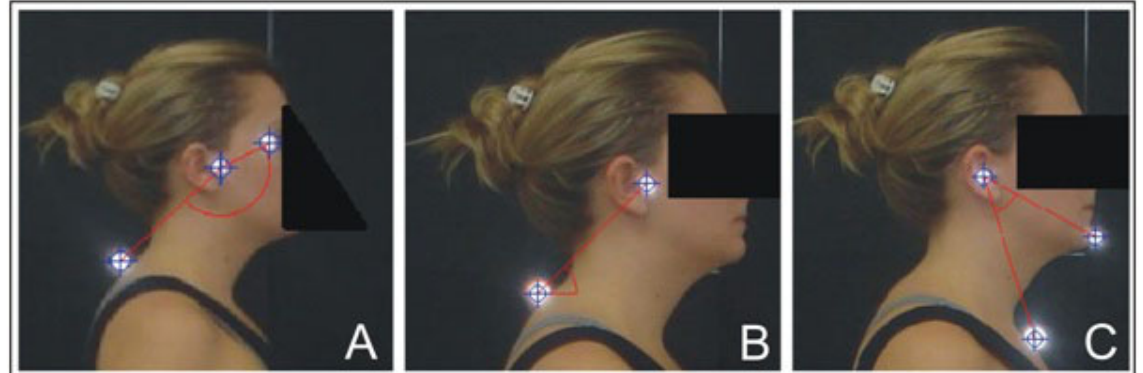
Fig. 1 – Craniocervical biophotogrammetric variables A) Angle FE – head flexion/extension of B) Angle A1 – Forward head posture; C) Angle A2 – Forward head